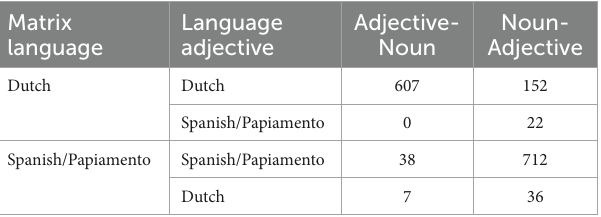
TABLE 4 Production of word orders by matrix language and adjective